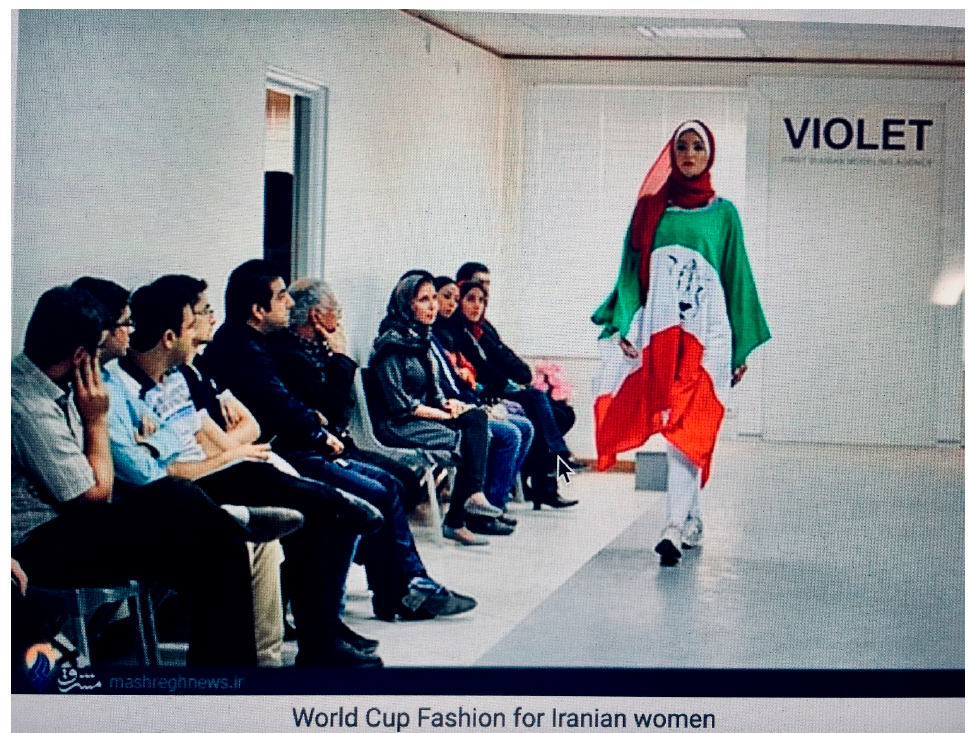
Figure 12. Iranian model presenting an outfit bearing the Iranian national flag’s colors in Tehran on June 24, 2014 Source: https://www.yahoo.com/news/iran-bans-fashion-show-organiser-over-flag- designs-144004947.html.